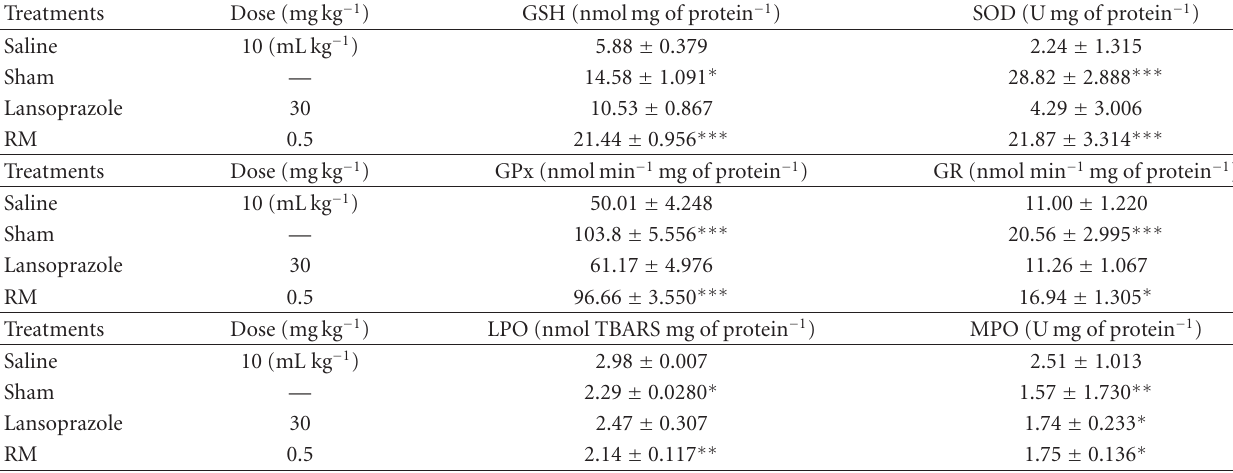
Table 2: E ff ect of RM on the antioxidant compounds and enzymes in ethanol-induced gastric ulcer in rats. Treatments